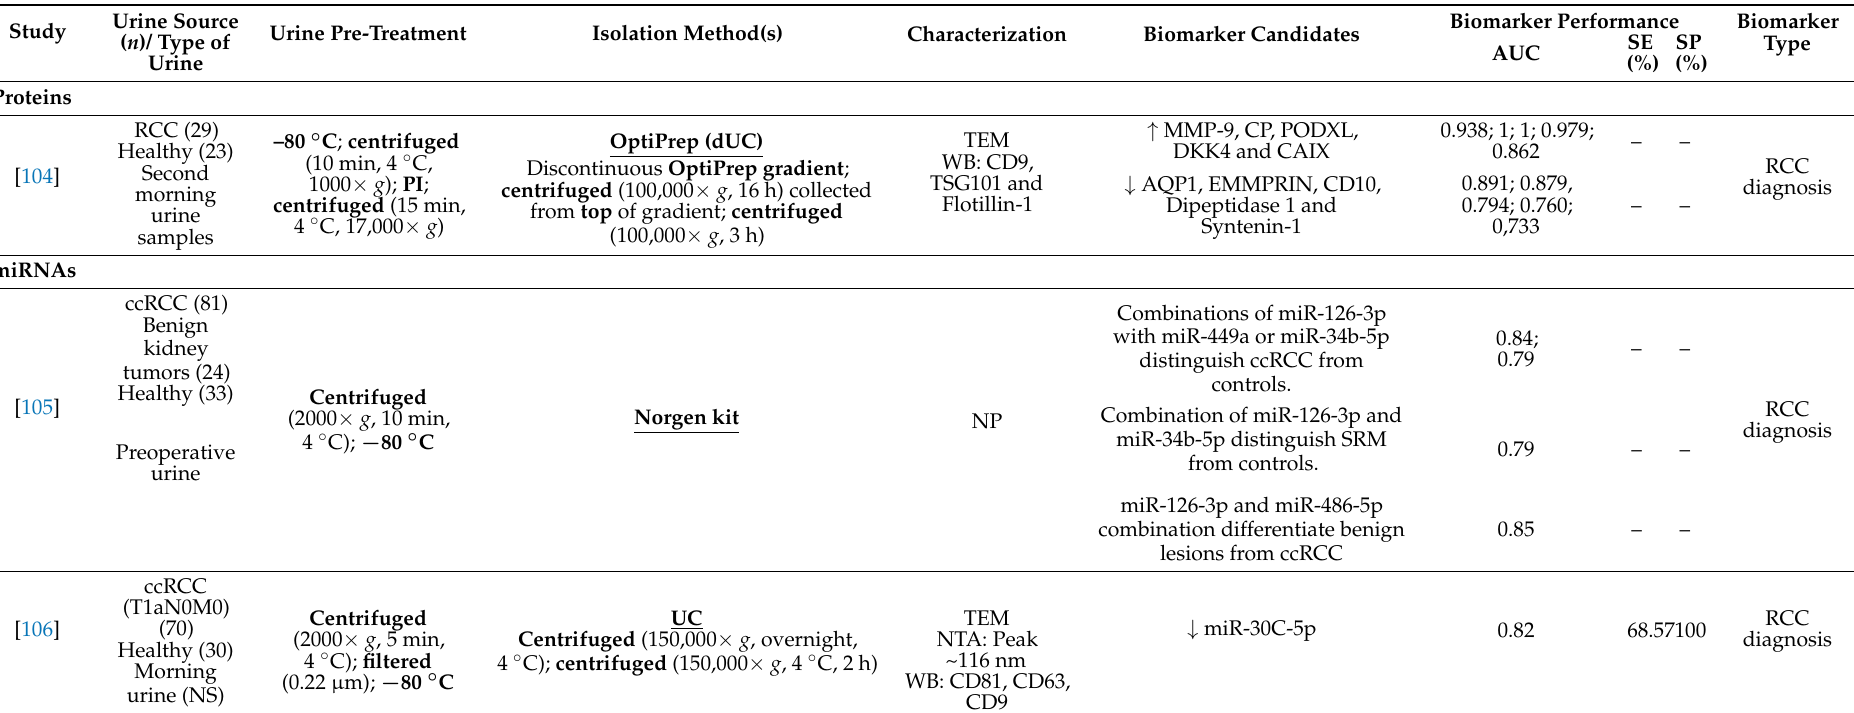
Table 4. uEV-derived protein and miRNA biomarker candidates in renal cell carcinoma